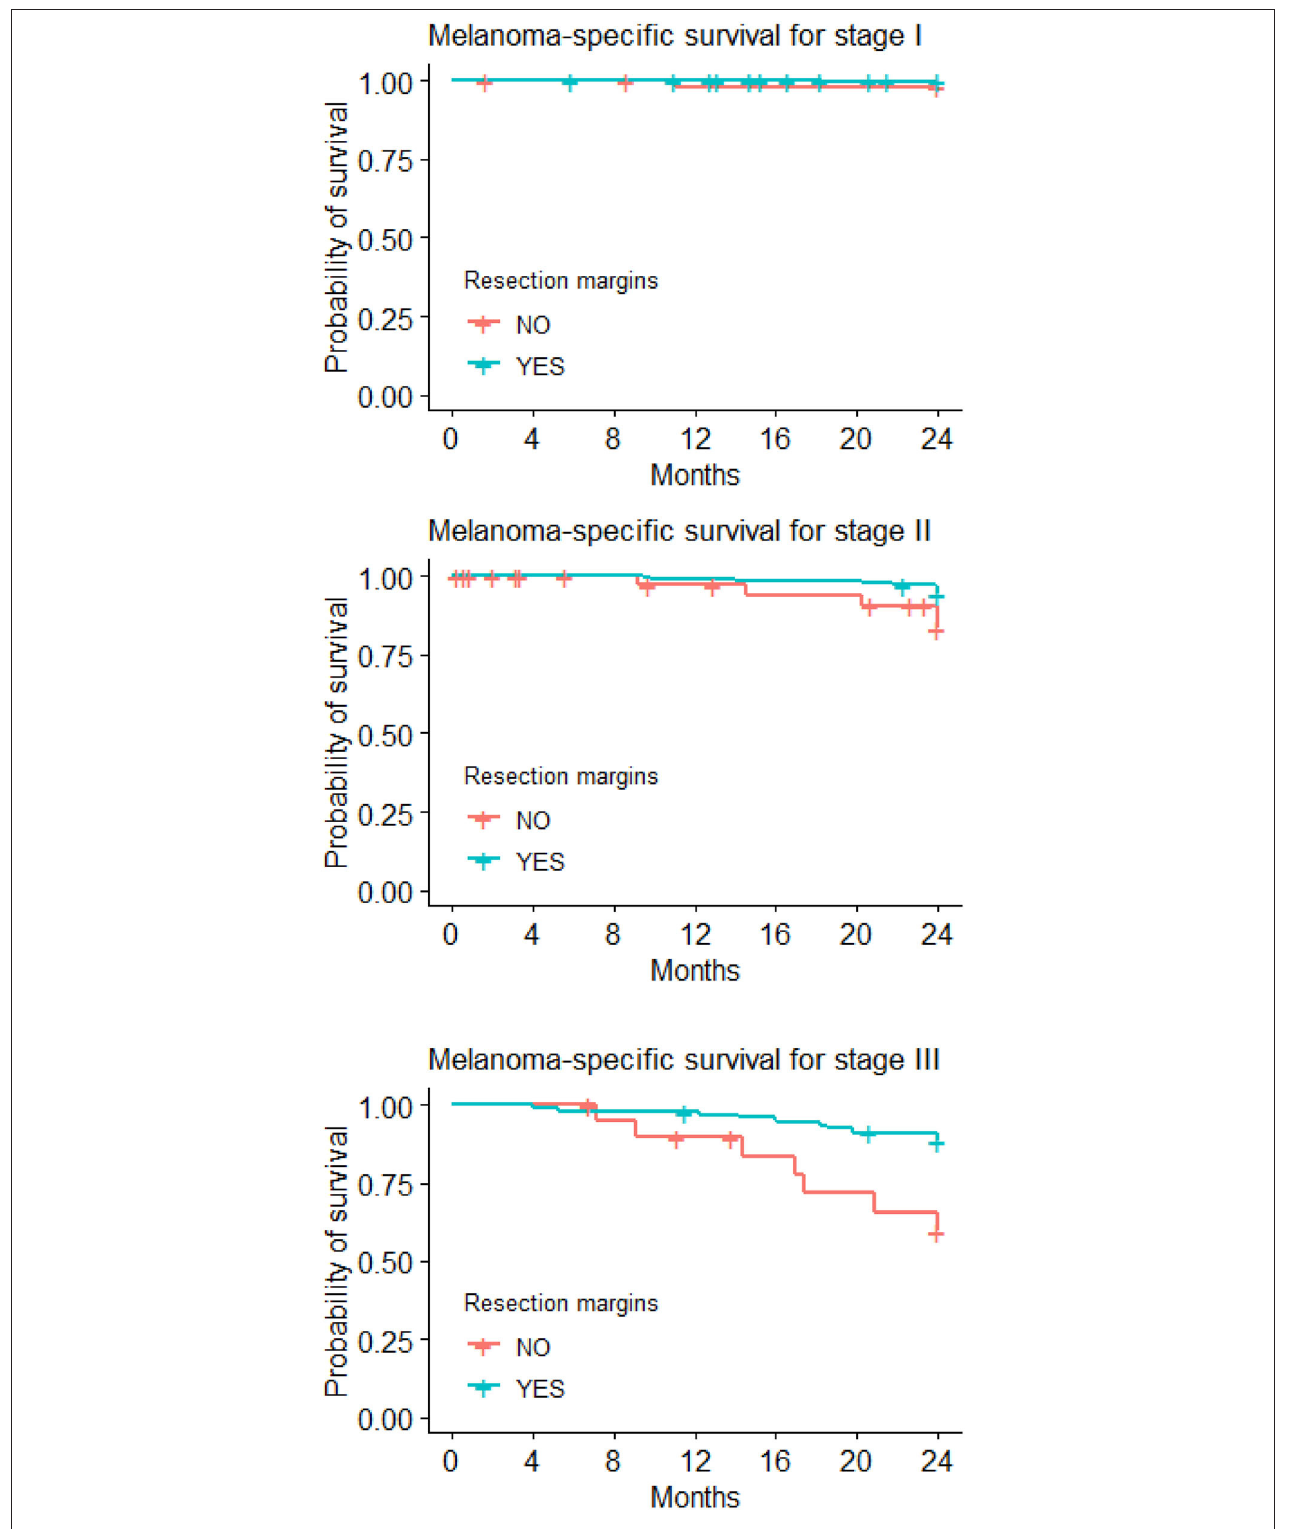
FIGURE 2 | Kaplan-Meier curves for melanoma-specific survival with/without wide local excision.